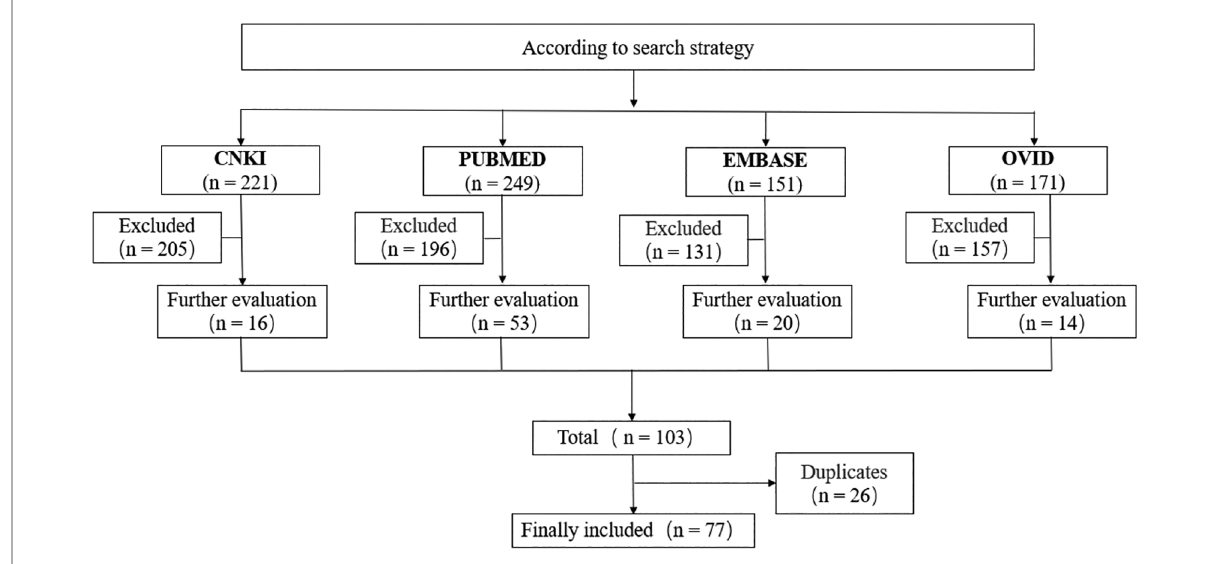
FIGURE 1 Flow diagram of study